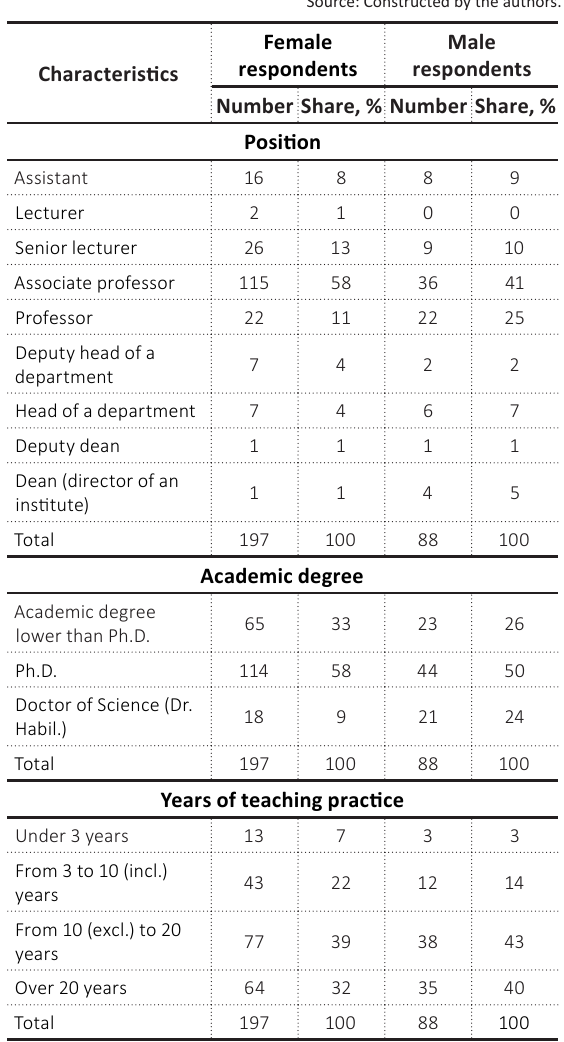
Table 1. Distribution of respondents by positions, academic degree, years of teaching practice and